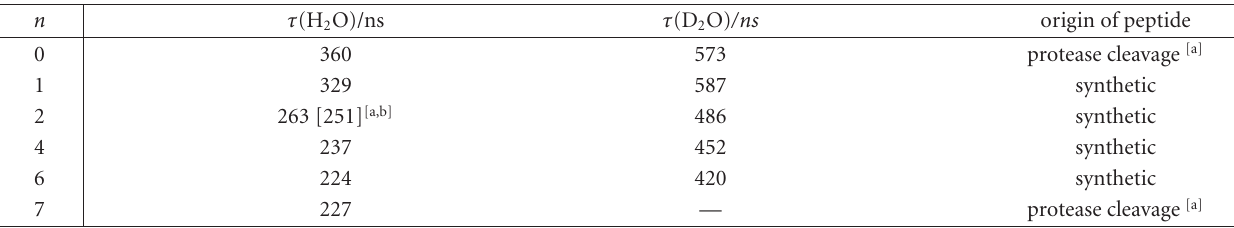
Table 5: Dependence of the intrinsic fluorescence lifetime of Dbo (in the absence of Trp as quencher) on peptide length in (Gly-Ser) n -Dbo- NH 2 peptides at 25 ◦